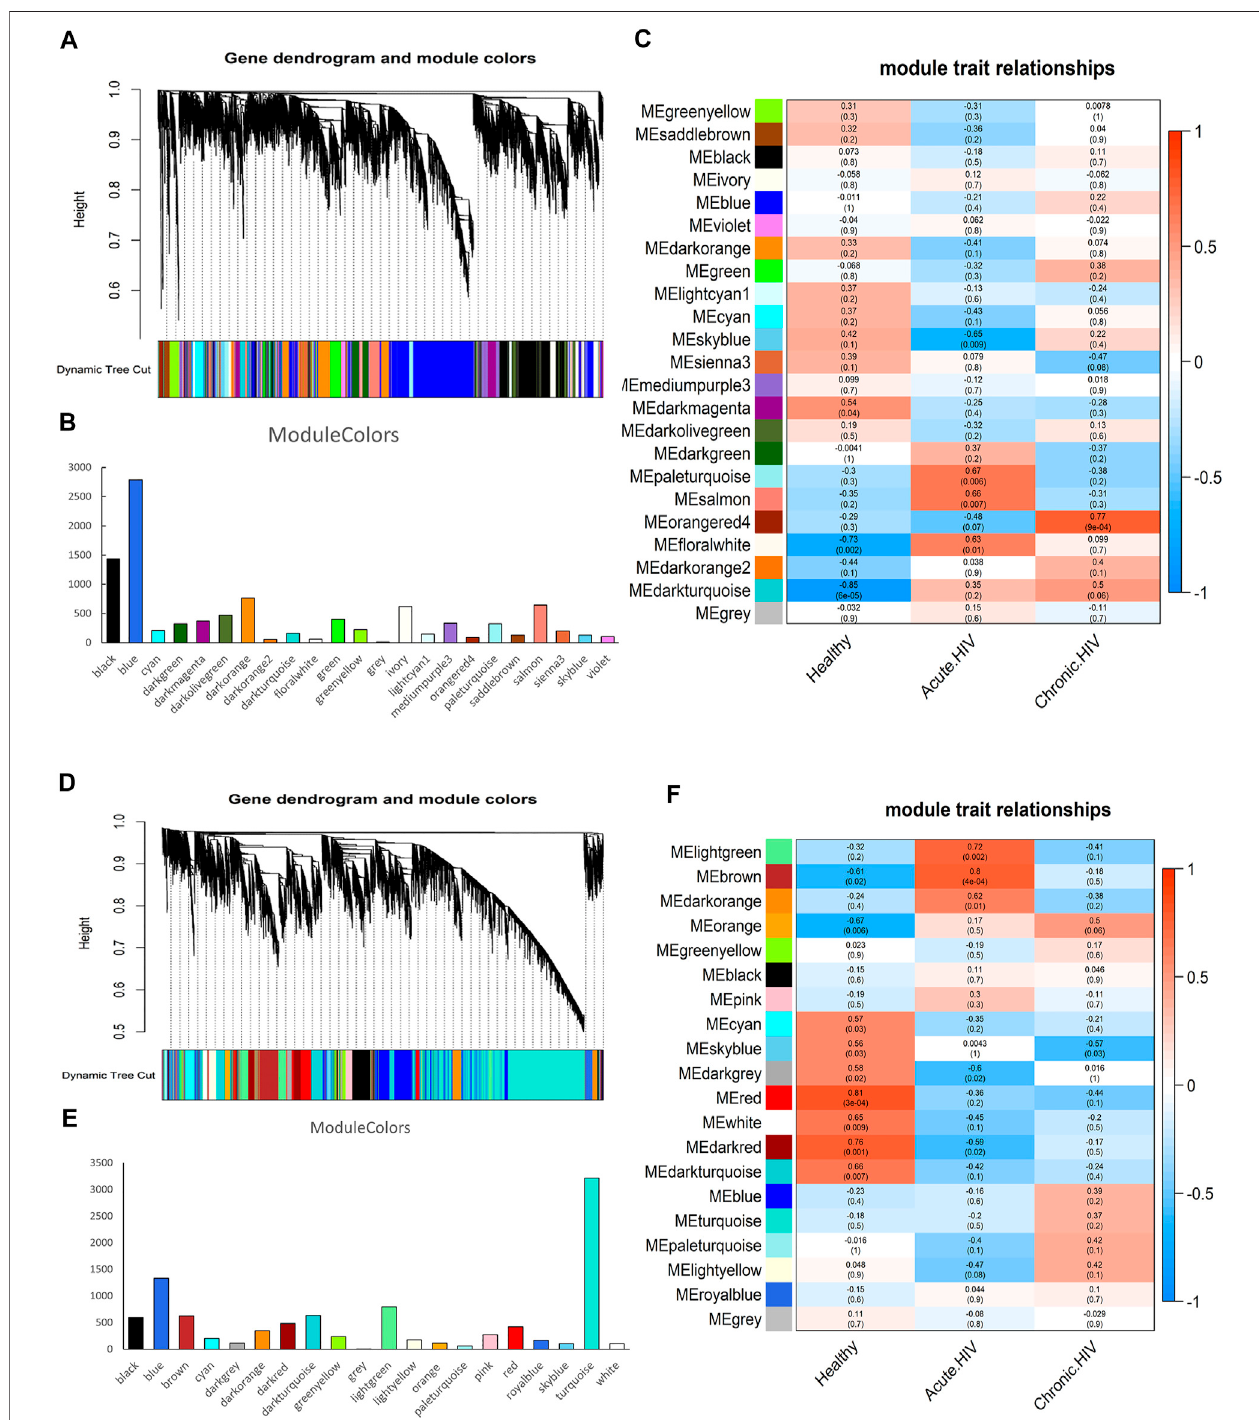
FIGURE 1 | Identi fi cation of the co-expressed gene modules. (A) Hierarchical clustering dendrogram of the co-expressed gene modules in CD4 + T cells. (B) The numberofgenescontainedin23modulesofCD4cells. (C) Correlationcoef fi cientsofmodule-traitrelationshipsinCD4 + Tcellsatdifferentinfectionperiodsareindicated bydifferentcolours. (D) Hierarchicalclusteringdendrogramoftheco-expressedgenemodulesinCD8 + Tcells. (E) Thenumberofgenescontainedin20modulesofCD8 cells. (F) Correlation coef fi cients of module-trait relationships in CD8 + T cells at different infection periods are indicated by different colours.